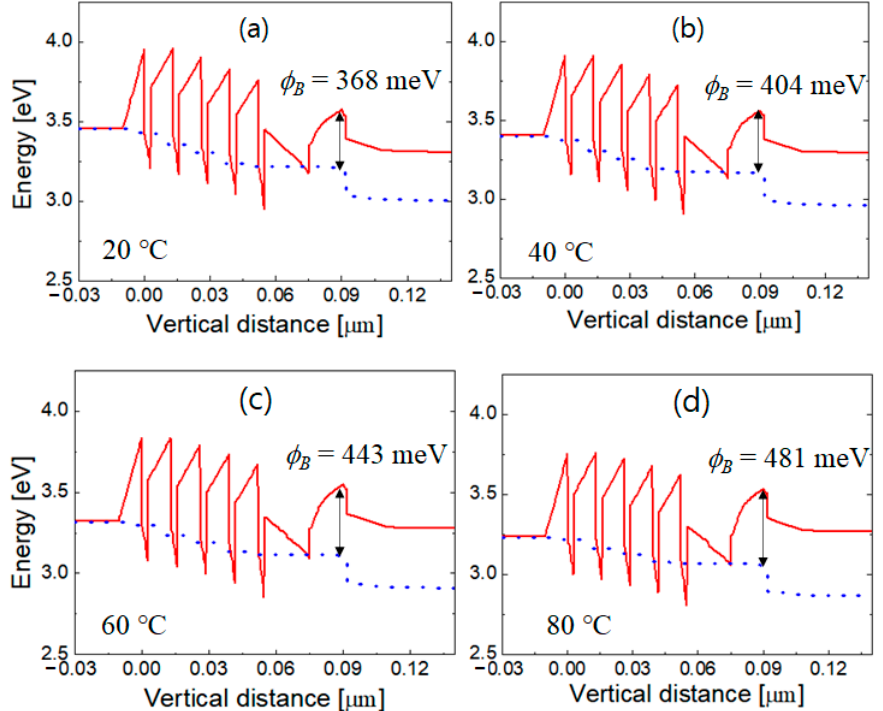
Figure 6. Conduction band diagrams at ( a ) 20, ( b ) 40, ( c ) 60, and ( d ) 80 ◦ C when the injection current is 350 mA. The solid and dotted lines indicate the conduction band edge and electron quasi-Fermi energy level, respectively. The effective electron potential ( φ B ) at 20, 40, 60, and 80 ◦ C is 368, 404, 443, and 481 meV, respectively. The origin of the horizontal axis corresponds to the position of the effective potential barrier height.